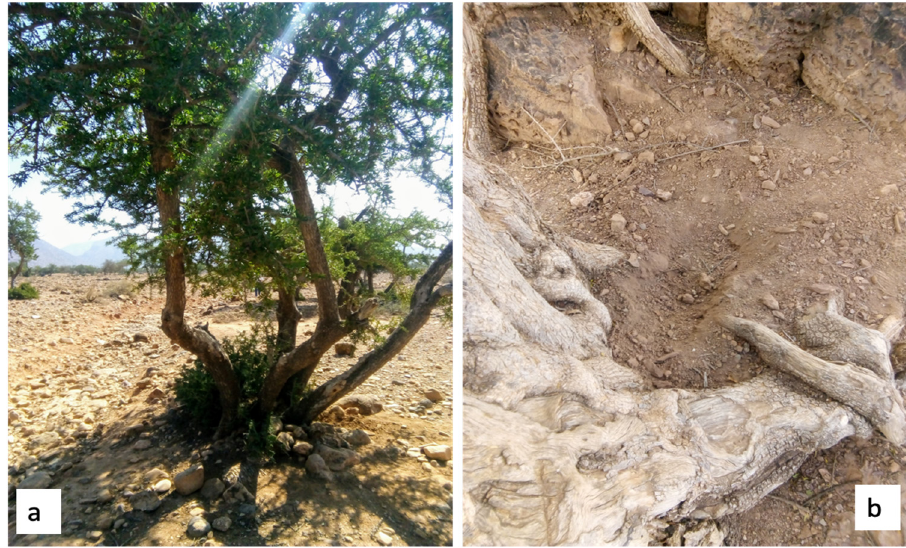
Figure 1. ( a ) Argania spinosa tree in the southwestern region of Morocco, and ( b ) one of the rizospheric soil.